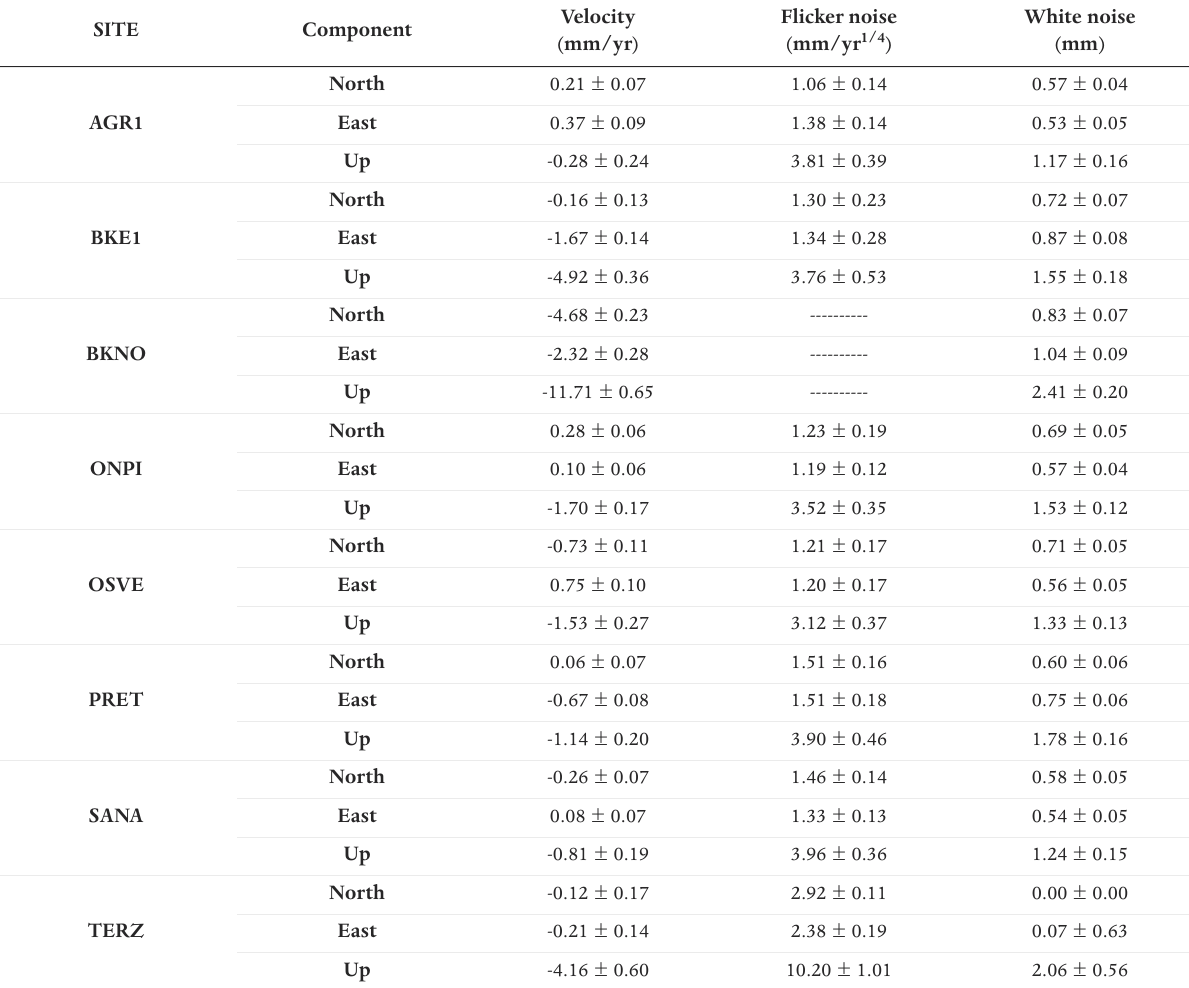
Table 3. Results of the time series analysis for Somma-Vesuvio GPS permanent stations. The analysis and noise characterization are per- formed with CATS software [Williams 2008]. Due to the short time series (only 1.5 years), the flicker noise for BKNO station is not